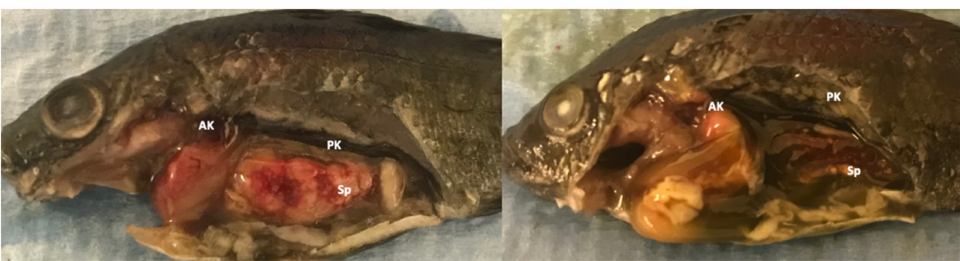
Figure 1. Gross findings in tilapia ( Oreochromis spp.) naturally infected with a novel megalocy- tivirus and Francisella orientalis . Fish showed classic gross lesions of piscine francisellosis including splenomegaly and renomegaly accompanied by multifocal yellow-white nodules, ascites, and cuta- neous melanosis. AK: Anterior kidney; PK: Posterior kidney, Sp: Spleen.